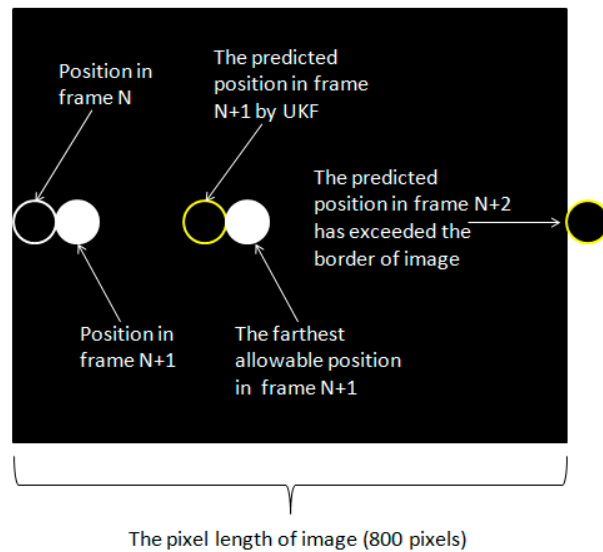
Figure 16. The calculation process of maximum motion speed of the positioning terminal.